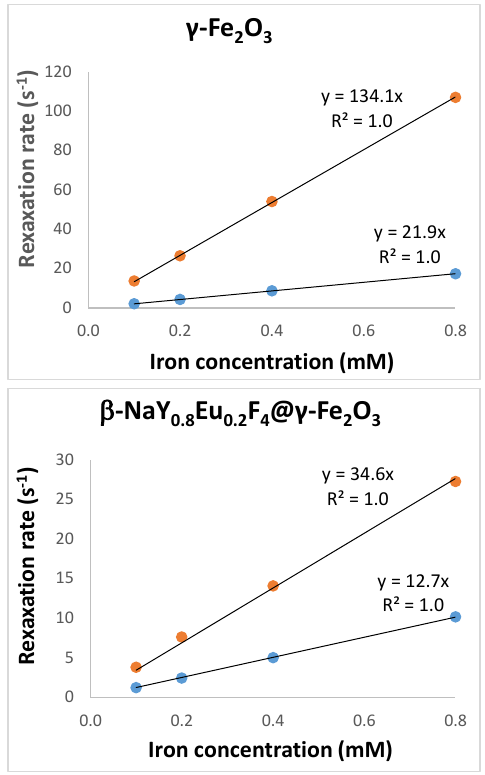
Figure 7. Determination of the longitudinal ( r 1 ) and transverse ( r 2 ) relaxivities of citrate coated samples dispersed in water at 37 °C for an applied static field of 1.41 T, by plotting the relaxation rates (inverse of the relaxation times) for T 1 (blue circles) and T 2 (red circles). The relaxation rates (1/ T i = 1 or 2 ) citrate of pure citrate solutions were subtracted so that the plots have zero intercept values. Table 2. Iron concentration [Fe] of the stock suspensions, as inferred from X-ray fluorescence (XRF) and colorimetry analyses. Average values of these data were taken to calculate the r 1 and r 2 relaxivities and assess the e ffi ciency of the obtained engineered multifunctional probes as magnetic resonance imaging (MRI) contrast agents compared to pure Fe 2 O 3 . Average hydrodynamic diameter and polydispersity index (PDI) as provided by dynamic light scattering (DLS) at 90 ◦ scattering angle.